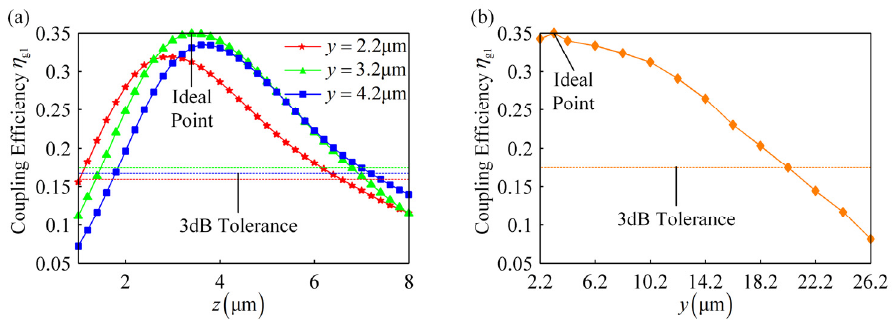
Figure 10. ( a ) Influence of the SMF position on the coupling e ffi ciency η g1 . ( b ) Influence of the bottom cladding thickness h on the coupling e ffi ciency η g1